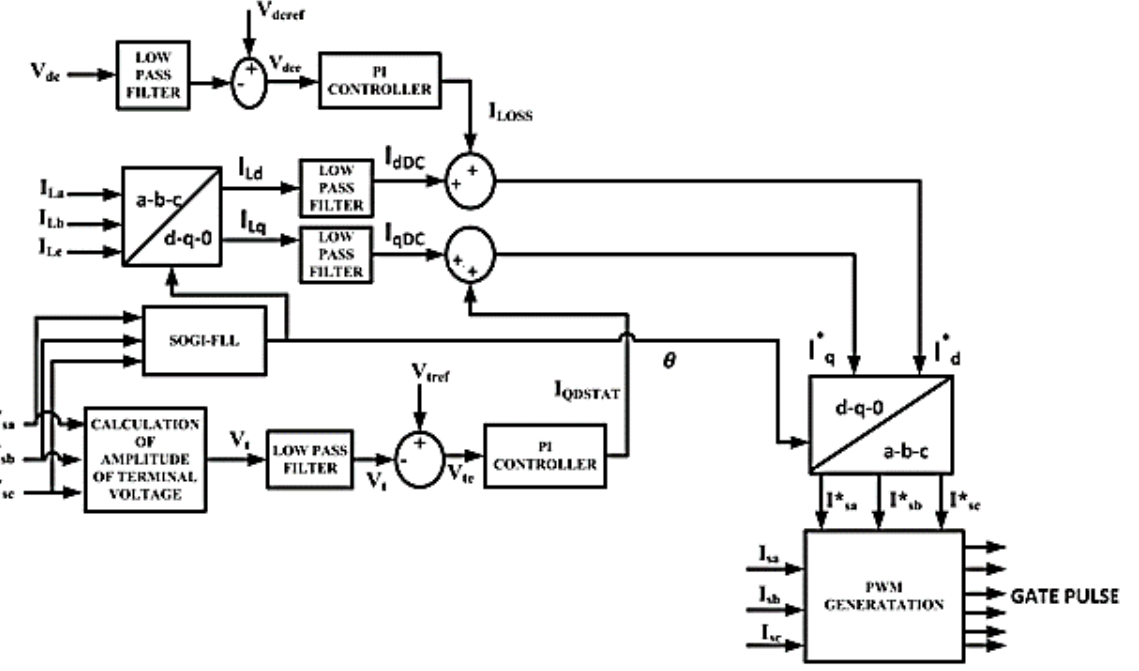
Figure 9. Block diagram of enhanced SRF SOGI-FLL controller [34].